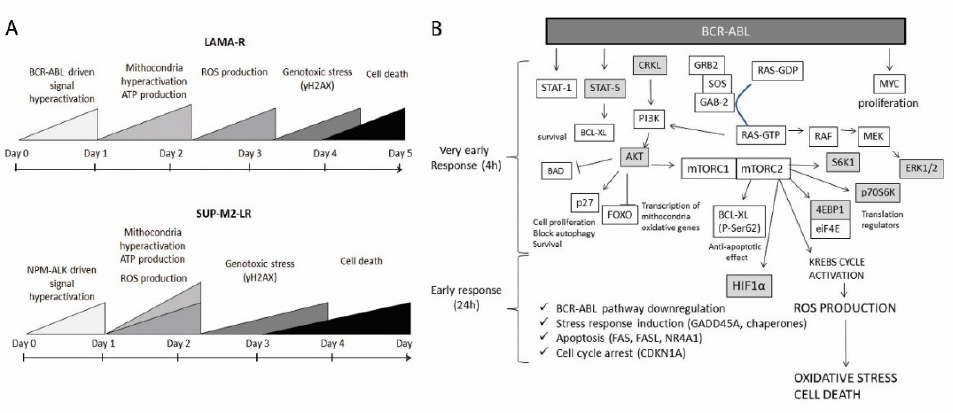
Figure 6. Representation of the model proposed. ( A ) Diagram comparing the temporal sequence of events leading to cell death in LAMA-R and in SUP-M2-LR cell lines. ( B ) Scheme representing the pathways activated upon drug withdrawal in LAMA-R. Dark boxes indicates the aforementioned